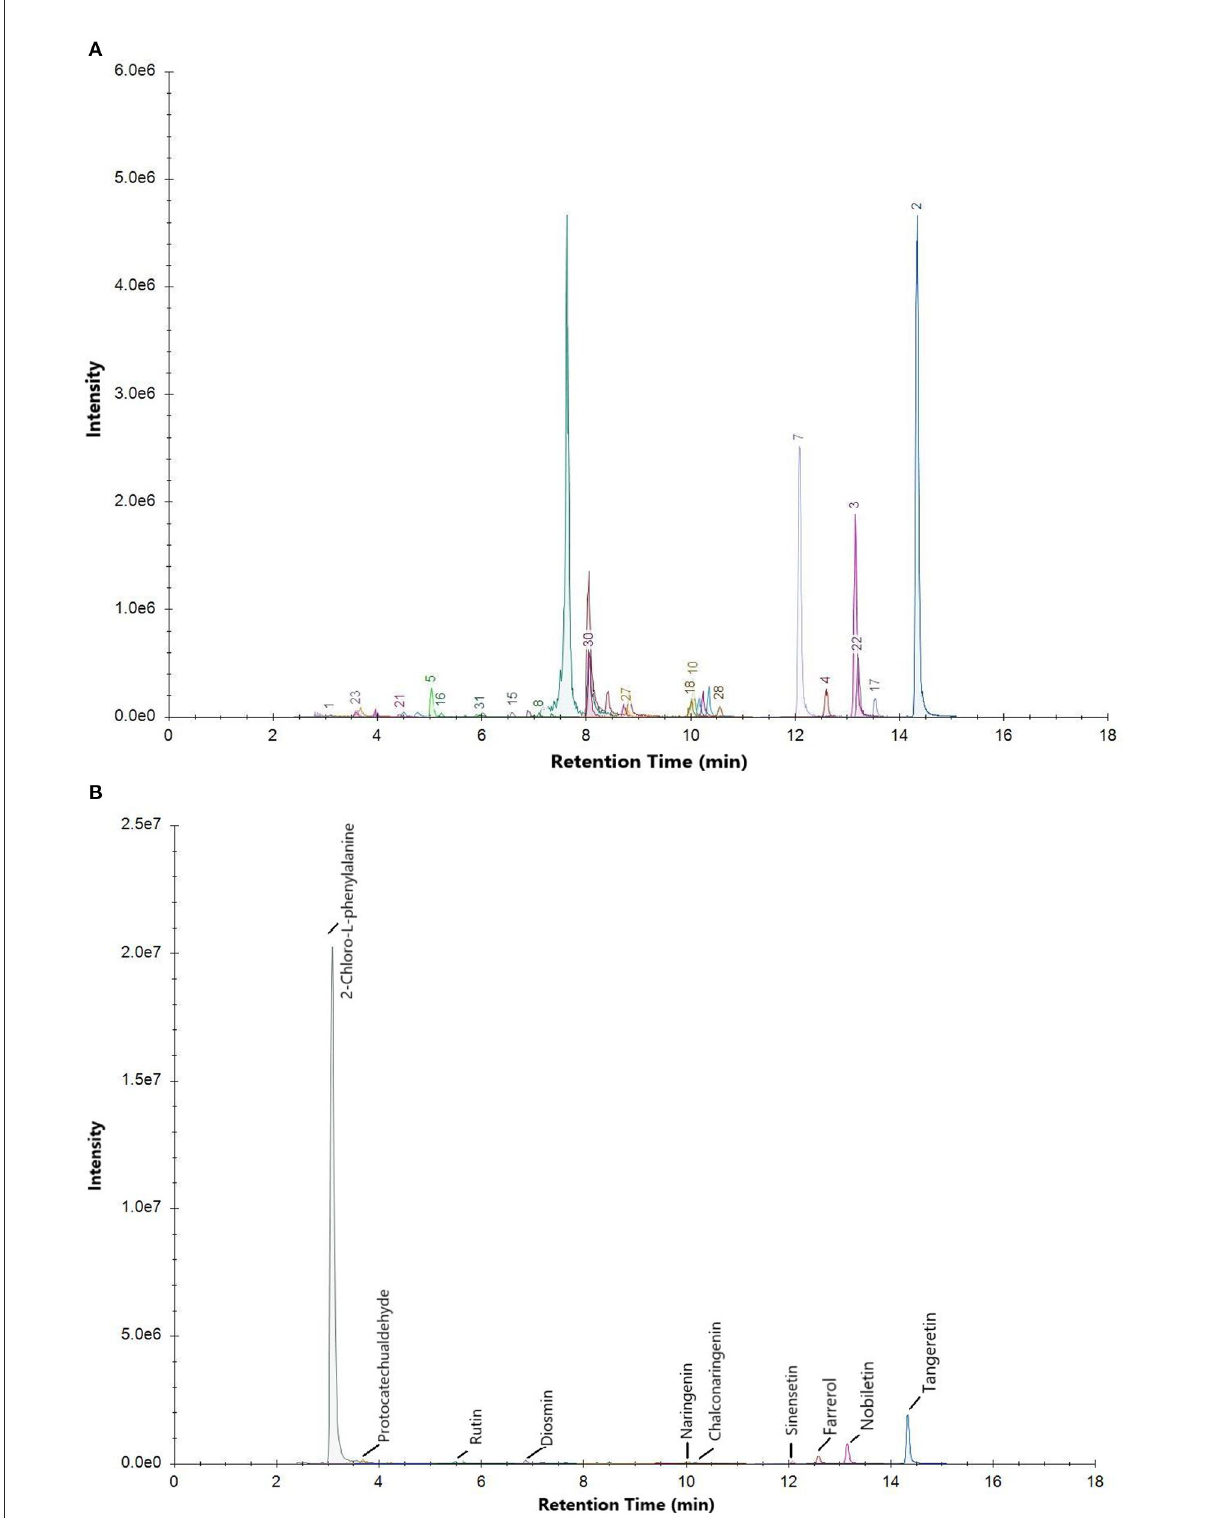
FIGURE2 Extracted ion chromatogram (EIC) of (A) mixed standard and (B)